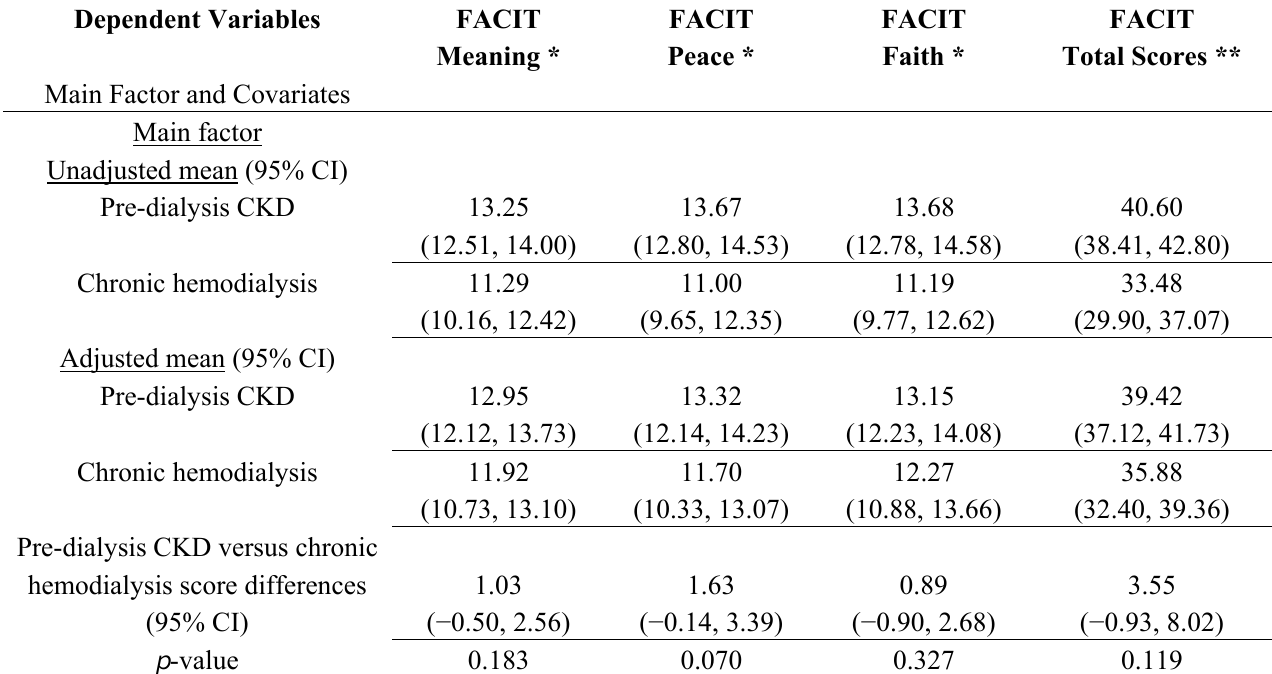
Table 3. Analysis of covariances of Functional Assessment of Chronic Illness Therapy – Spiritual Well-Being (FACIT) domain and total scores as the dependent variables by patient treatment groups and